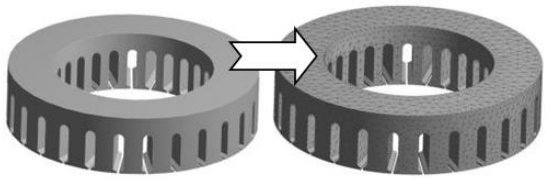
Figure 18. Finite element simulation model of the stator core.